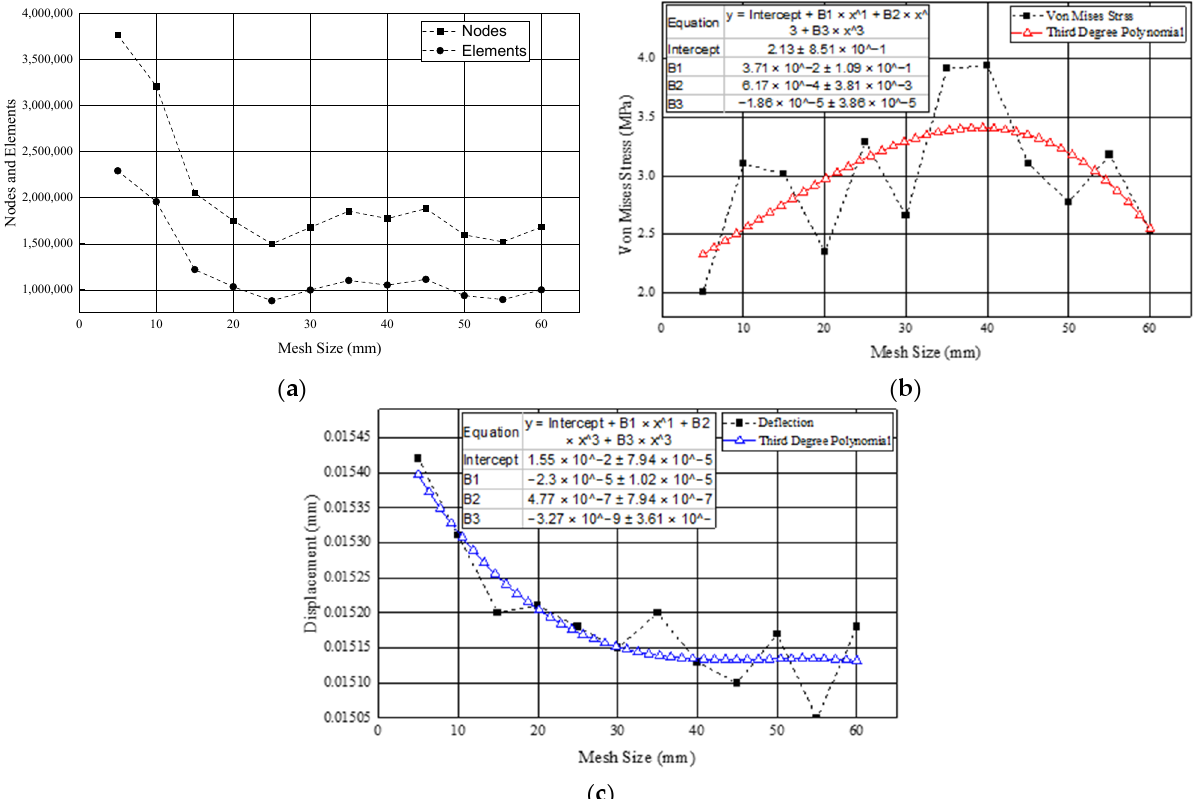
Figure 4. Trend Line Comparison Results of Prior Study: ( a ) Mesh Size against Nodes and Elements; ( b ) Mesh Size against Von Mises Stress; ( c ) Mesh Size against Displacement.